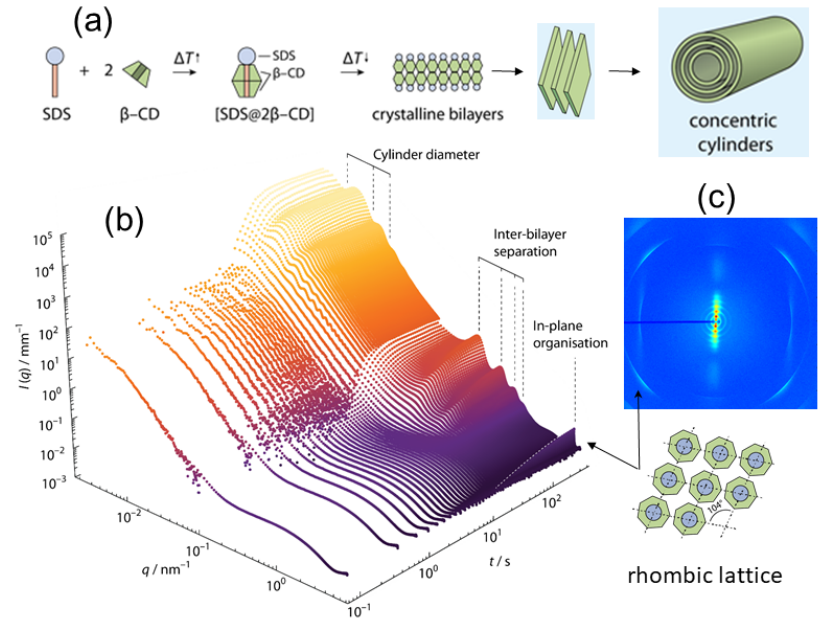
Figure 8. Hierarchical self-assembly of SDS and β -CD to form microtubules upon cooling a 10 wt% solution from 75 ◦ C to 25 ◦ C. ( a ) Schematic representation of the structural moieties involved in the assembly process. Two β -CD molecules and one SDS molecule form a capsid at higher temperature due to hydrophobic interactions as the interior of circular polysaccharides is slightly hydrophobic. Upon cooling, the capsids organize to crystalline bilayers, which then roll to form single-walled microtubes and subsequently the multilamellar structure develops by an inward growth. ( b ) Evolution of the SAXS and USAXS profiles showing the sequence of growth represented in panel (a). ( c ) 2D SAXS pattern from an oriented sample in the final state depicting the sawtooth Bragg peaks from a curved rhombic lattice, and form and structure factors of the multilamellar stacks within the tube walls. Adapted from J. Landman et al. [74] distributed under a Creative Commons Attribution Non Commercial License 4.0 (CC